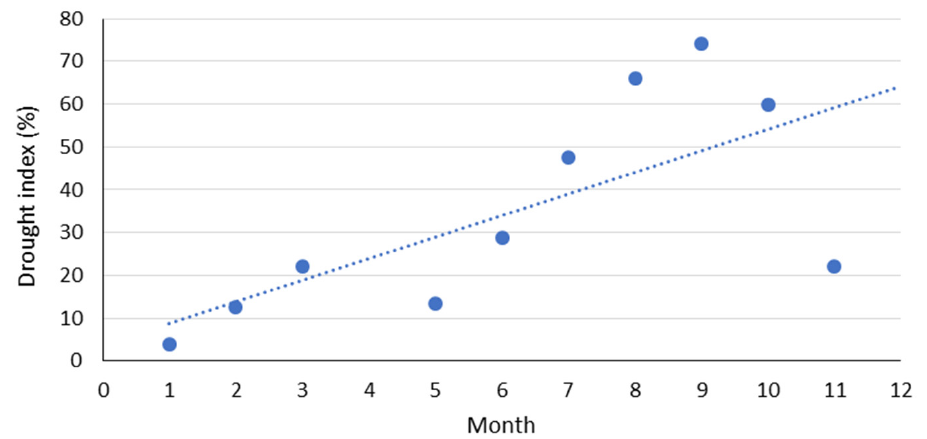
Figure 7. Monthly drought index trend in the Dodokan Watershed from 2009–2020.